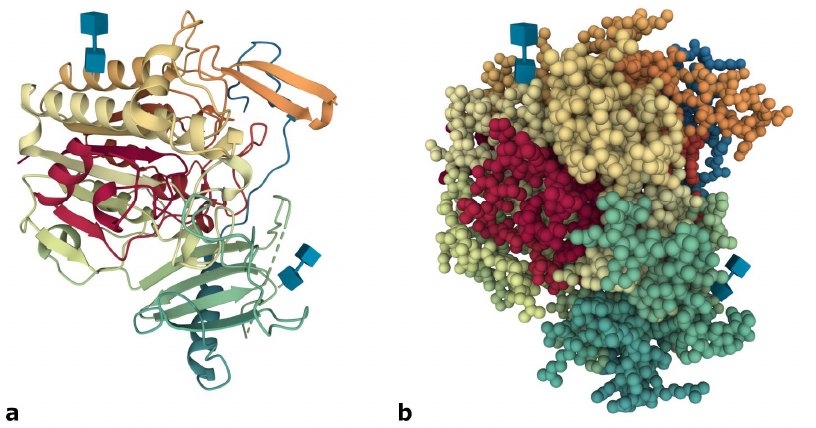
Figure 1. Crystal structure of ASB protein shown by cartoon ( a ) and spacefill ( b ) representations. Image from the RCSB PDB (http://www.rcsb.org/, accessed on 3 September 2021) [15] of PDB ID 1FSU [12], created with Mol* viewer